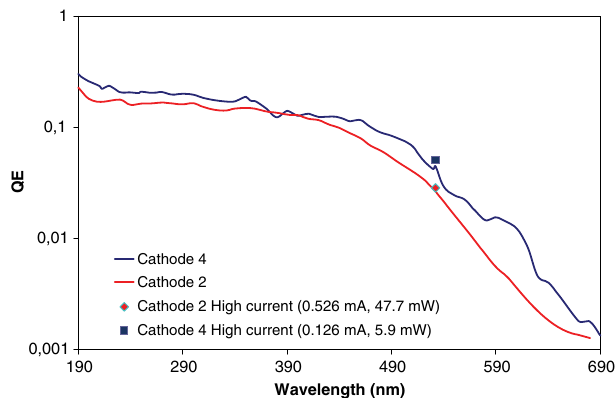
FIG. 6. 703.75 MHz—half cell BNL/AES cavity. Courtesy of Gary McIntyre, BNL.